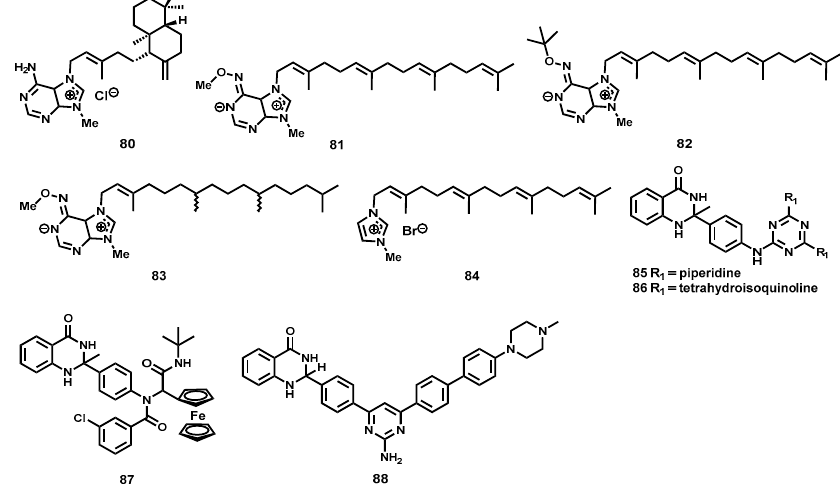
Figure 12. Natural product-based synthetic/semisynthetic antileishmanial compounds.